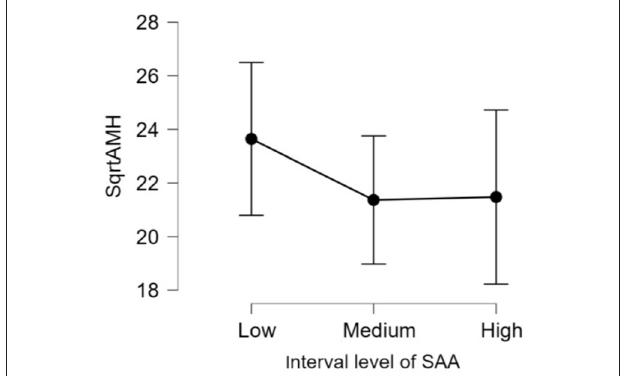
FIGURE 4 | The 95% confidence interval of the mean for each group. The mean and standard deviation (mean ± SD) score of interval level of fourth root of SAA levels are as follows: Low = (1.1 ± 0.2), Medium = (1.5 ± 0.1), and High = (1.9 ± 0.3). The differences in all level are not significant